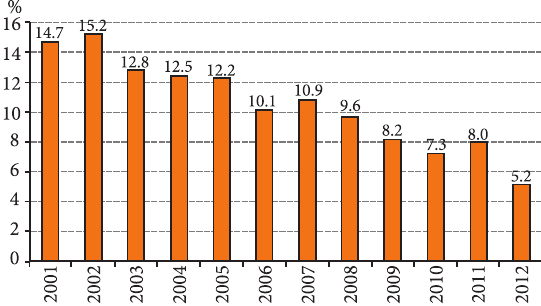
Fig. 6. Distribution of accidents caused by drivers under the